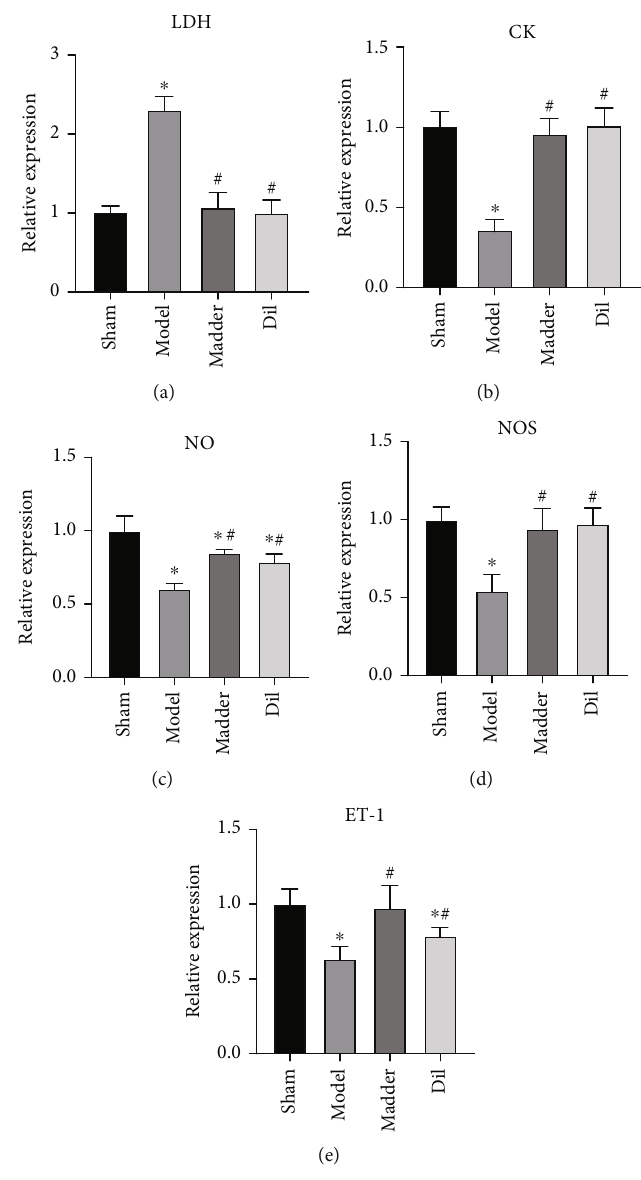
Figure 3: E ff ect of madder treatment on endothelial cell and myocardial cell function in rats: (a, b) ELISA assay was used to detect the expression of myocardial cell functional markers creatine kinase (CK) and lactate dehydrogenase (LDH); (c – e) ELISA assay was used to detect the expression of endothelial cell functional markers NO, NOS, and ET-1. ∗ P < 0 : 05 , compared with the sham group; # P < 0 : 05 , compared with the model